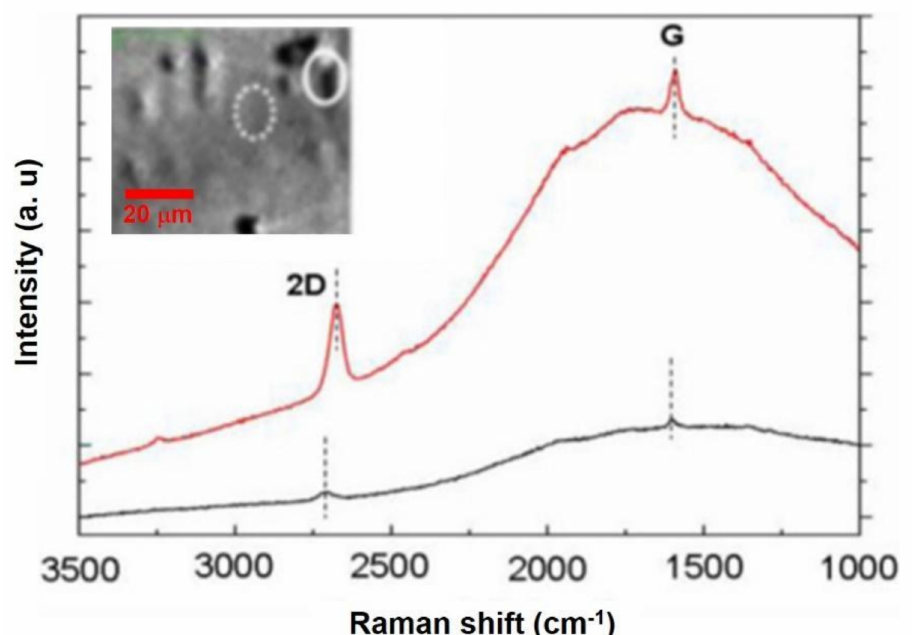
Figure 1. Raman spectra of CVD-MG deposited on Cu foil substrate. Inset showed the bright-field optical microscopy image of Cu foil substrate subsequent to the complete growth of CVD-MG. The image shows partial distribution of irregular Cu domains in the micrometer range. The Raman spectra denoted by the red and black plots were obtained from the solid and dotted circle regions of the inset image. Reprinted with permission from ref. [6].